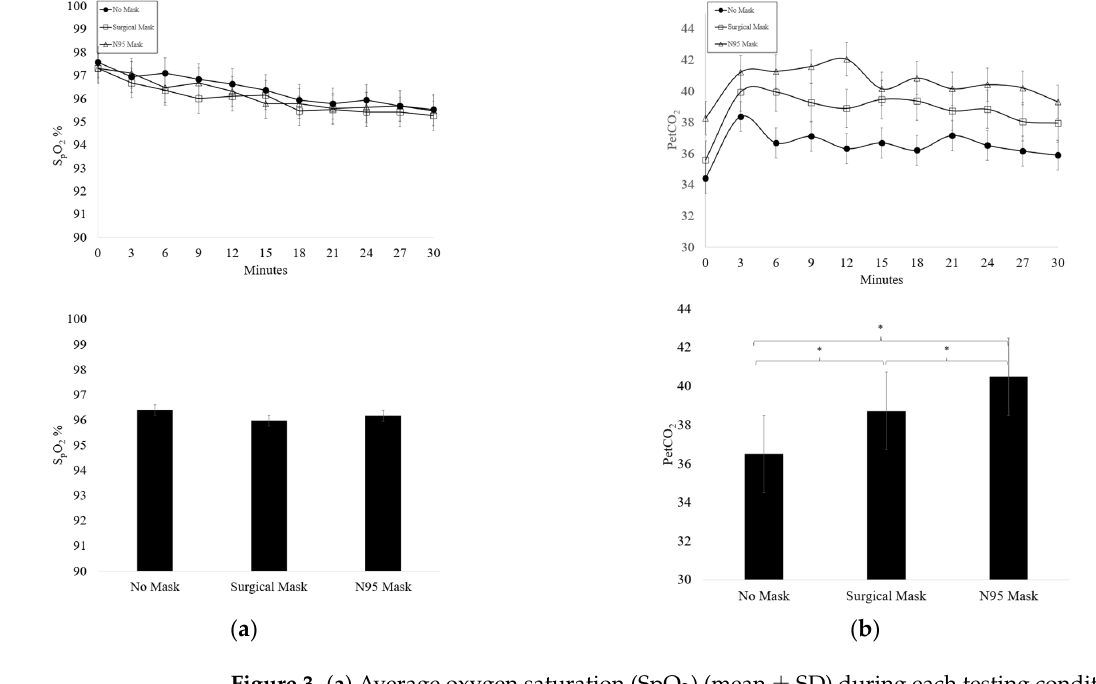
Figure 3. ( a ) Average oxygen saturation (SpO 2 ) (mean ± SD) during each testing condition ( n = 19); ( b ) average patient end-tidal carbon dioxide (PetCO 2 ) (mean ± SD) during each testing condition ( n = 19) * Significant main effect for condition ( p < 0.05).